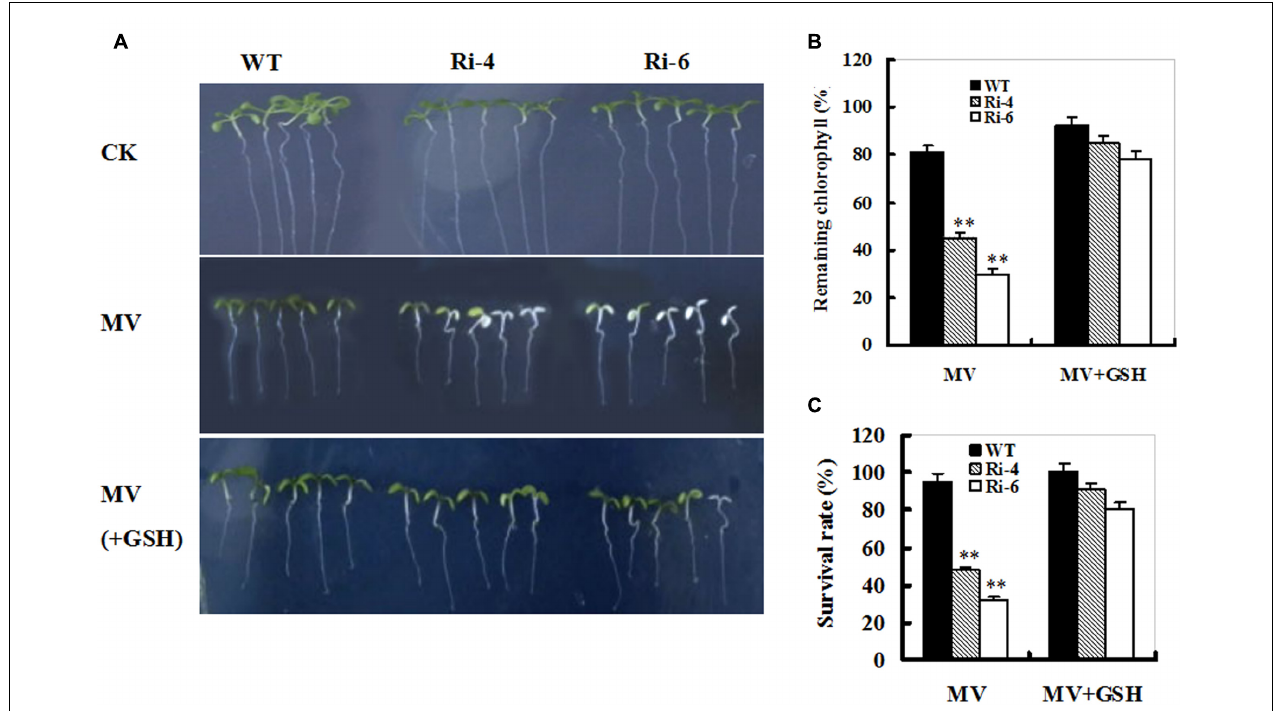
FIGURE 6 | Effect of exogenous GSH on response of wild-type and SiR under-expressing plants to oxidative stress. (A) Representative growth phenotypes of WT and RNAi seedlings when exposed to MV and MV + GSH. Seven-day-old seedlings of WT and RNAi lines (Ri-4 and -6) were vertically growing on 1/2 MS medium supplemented with 0 (CK), MV(5 µ M), and MV(5 µ M) plus GSH (10 mg/L) for 7 days. (B) Relative residual chlorophyll (%) in the wild-type and RNAi lines after MV and MV plus GSH treatments. Values are mean ± SE, n = 15. ∗∗ t -test, with P < 0.01. (C) Survival rates (%) under MV stress in (B) were determined as the number of visibly green plants after 7 days. Values are mean ± SE, n = 30. ∗∗ t -test, with P <